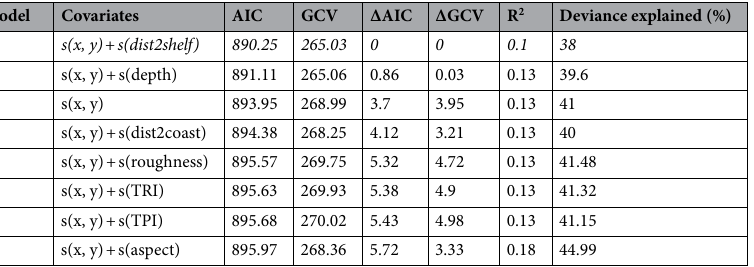
Table 3. Models tested for abundance estimation. Model: model name as used throughout the manuscript (model in italics indicates selected model); covariates: the covariates used in the gam (the s indicates thin- plate smoothing terms); AIC: Akaike Information Criterion; GCV: Generalised Cross Validation Score; ΔAIC: difference in AIC (compared to model with lowest AIC); ΔGCV: difference in GCV (compared to model with lowest GCV); R 2 : pseudo R square measure of model fit; Deviance explained: alternative metric for goodness of fit.